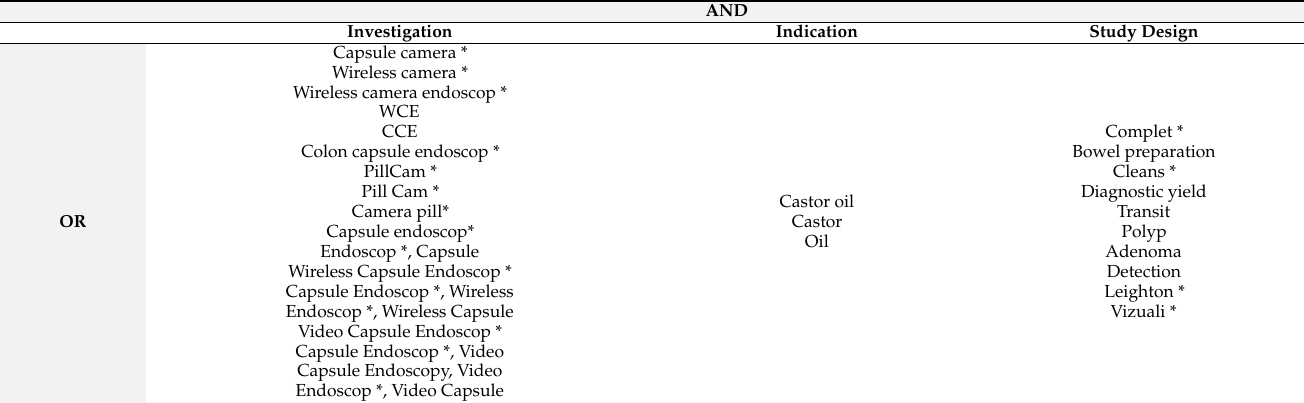
Table A1. Search strategy to identify relevant